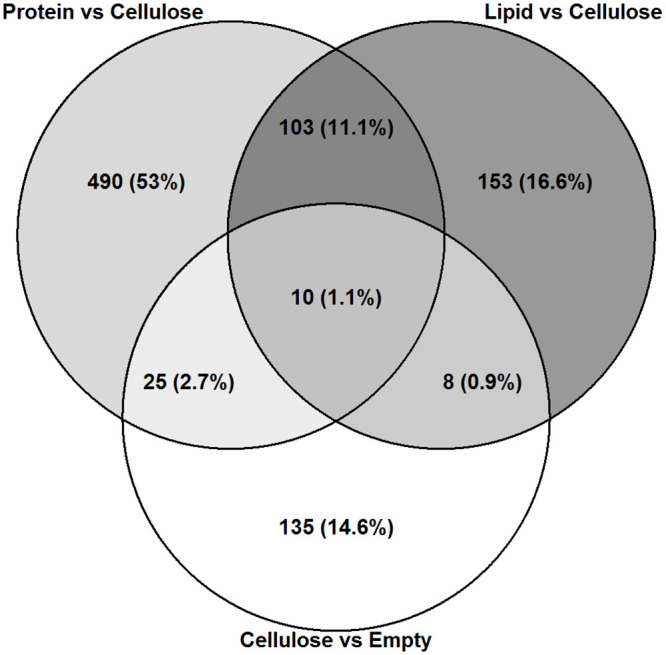
Nutrient stimuli induces changes in gene expression in Segment 1.Venn diagram showing differentially expressed genes (p < 0.01) in intestines administered a protein bolus (n = 6) versus cellulose (n = 7), lipid (n = 6) versus cellulose, and cellulose versus empty groups following DESeq2 analysis of RNA seq data.